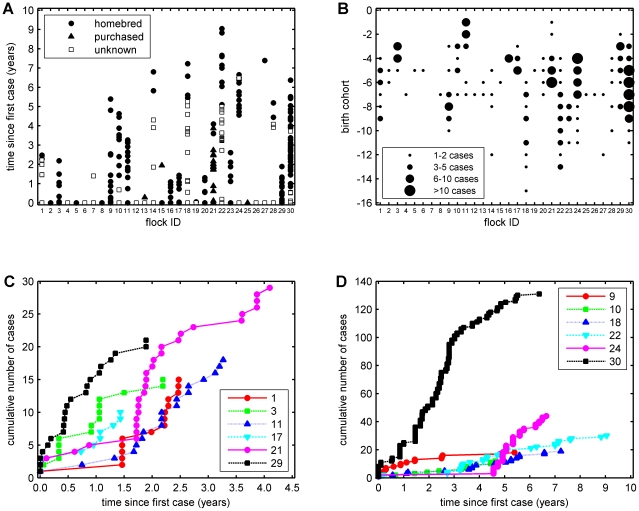
Time-course of scrapie outbreaks in 30 sheep flocks in the UK.(a) Occurrence and origin of cases within each outbreak. Time zero corresponds to the first case of scrapie in each flock. The origin of cases is that recorded in the Scrapie Notifications Database (SND). (b) Frequency of cases by birth cohort. Time zero corresponds to the first birth cohort for which the farmer had received genotype results from the IAH. The date that the farmer of flock 7 was informed of his genotypes was unknown and is not displayed. (c,d) Epidemic curves showing the cumulative number of cases in (c) outbreaks <50 months long; and (d) outbreaks >50 months long. Legends indicate flock identification number.